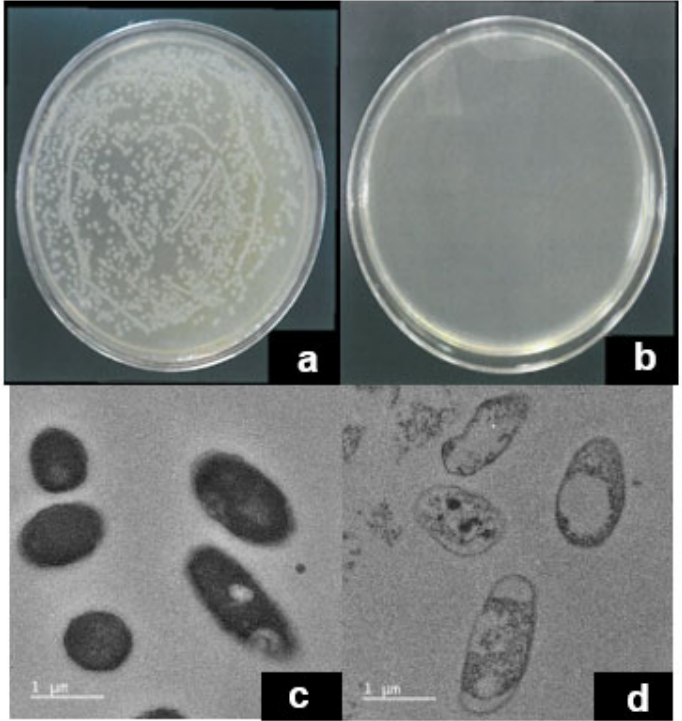
Figure 8. Bacterial disinfection image of ( a ) NWPF, ( b ) PNT/NWPF after 2 h treatment. TEM images of E. coli , ( c ) before inactivation with PNT and ( d ) after inactivation with PNT.